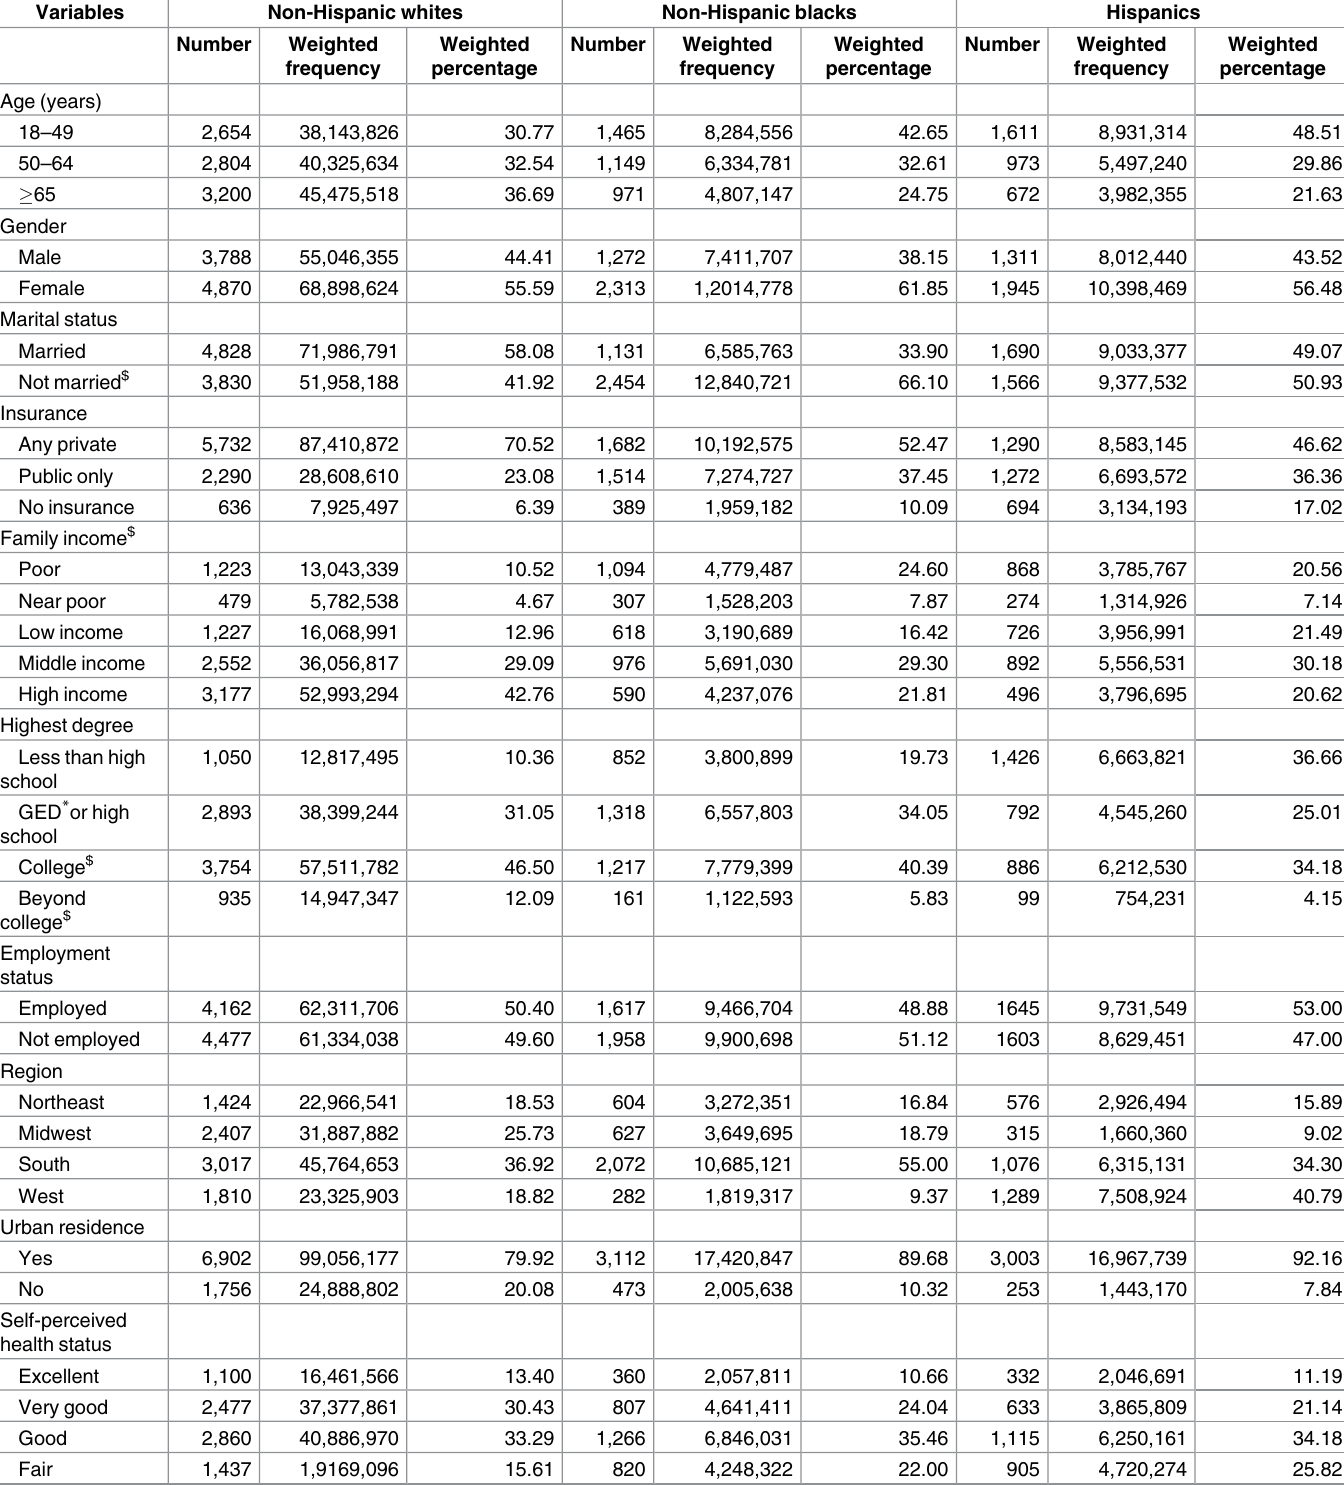
Table 1. Characteristics of study population across racial and ethnic groups (to be continued), N =